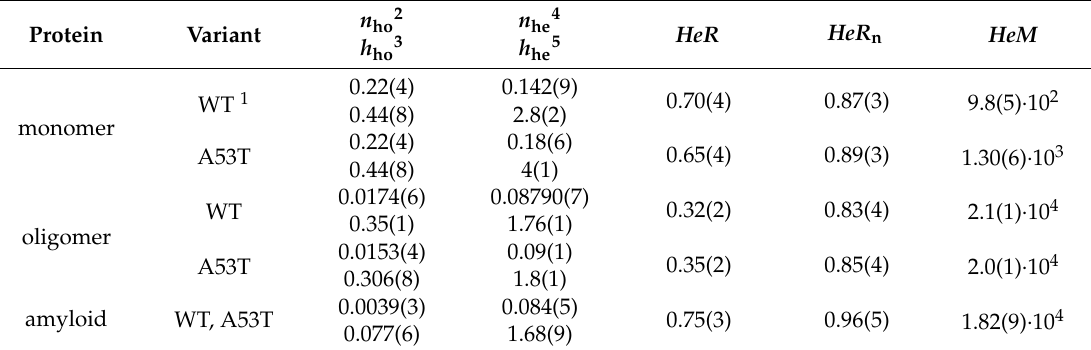
Table 2. Homogeneously or heterogeneously bound amounts of water, and dynamic parameters. For the detailed definitions of the parameters, see Supplemental Information of [18]. The error in the last digit is given in